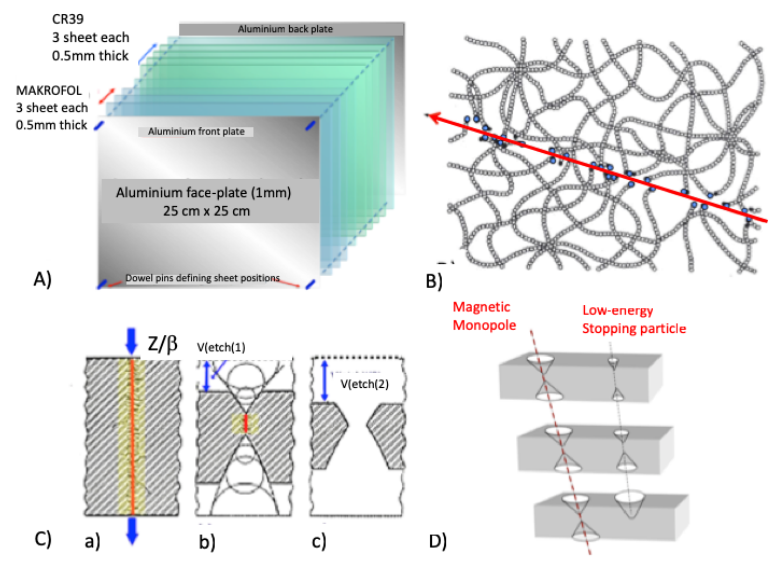
Figure 3. ( A ) A MOEDAL NTD stack; ( B ) a depiction of a HIP damaging NTD plastic as it traverses